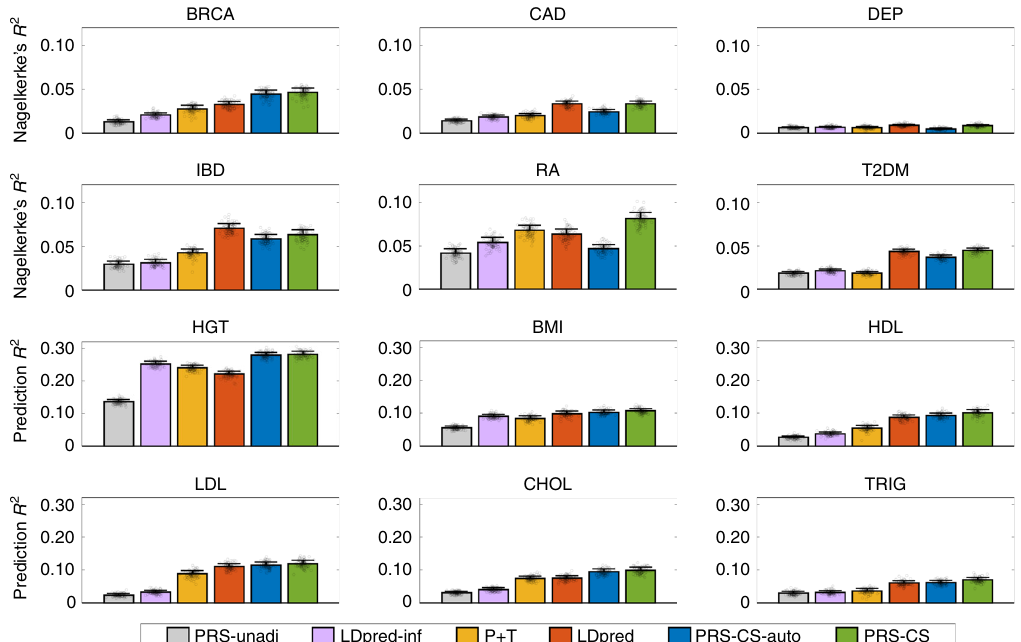
Fig. 2 Prediction accuracy of six polygenic prediction methods in the Partners HealthCare Biobank. Posterior effect sizes of single nucleotide polymorphisms (SNPs) were trained with large-scale genome-wide association summary statistics, using the 1000 Genomes Project European sample as an external linkage disequilibrium (LD) reference panel. Polygenic scores were applied to predict six curated common complex diseases — breast cancer (BRCA), coronary artery disease (CAD), depression (DEP), in fl ammatory bowel disease (IBD), rheumatoid arthritis (RA), and type 2 diabetes mellitus (T2DM), and six quantitative traits — height (HGT), body mass index (BMI), high-density lipoproteins (HDL), low-density lipoproteins (LDL), cholesterol (CHOL), and triglycerides (TRIG). The Partners HealthCare Biobank sample for each disease and quantitative phenotype was repeatedly and randomly split into a validation set comprising 1/3 of the data and a testing set comprising 2/3 of the data. Tuning parameters ( P -value threshold in P + T, fraction of causal SNPs in LDpred, and global shrinkage parameter in PRS-CS) were selected in the validation data set, and the predictive performance was assessed in the testing set. For disease (case – control) phenotypes and quantitive traits, prediction accuracy was measured by the Nagelkerke ’ s R 2 and R 2 , respectively, averaged across 100 random splits. The error bar indicates the standard deviation of prediction accuracy across 100 random splits. Prediction accuracy for each random split is overlaid on the bar plot (black